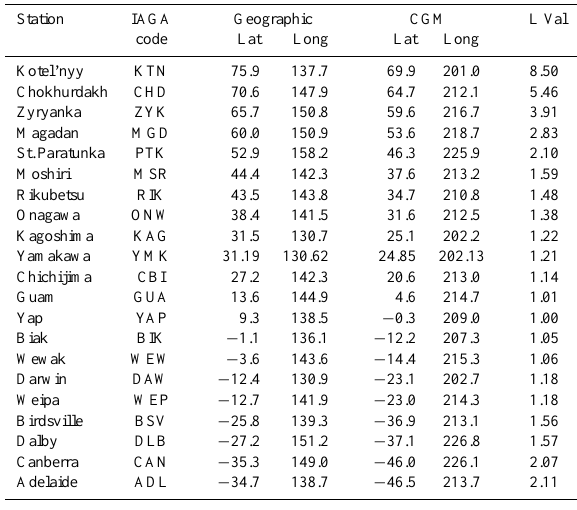
Table 2. Location of 210 ◦ magnetometer stations.